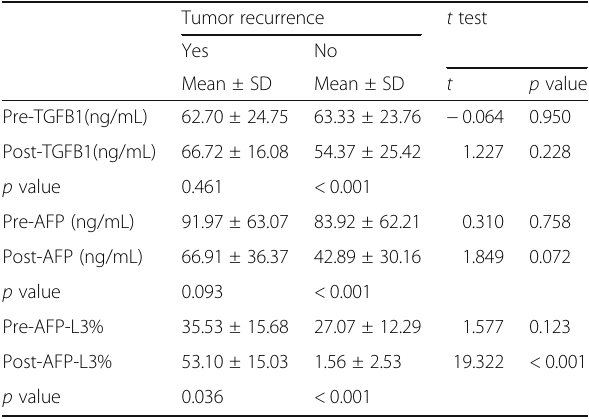
Table 2 Comparison between the tumor recurrence group and group with no tumor recurrence regarding pre- and post- radiofrequency TGFB1, AFP, and AFP-L3%